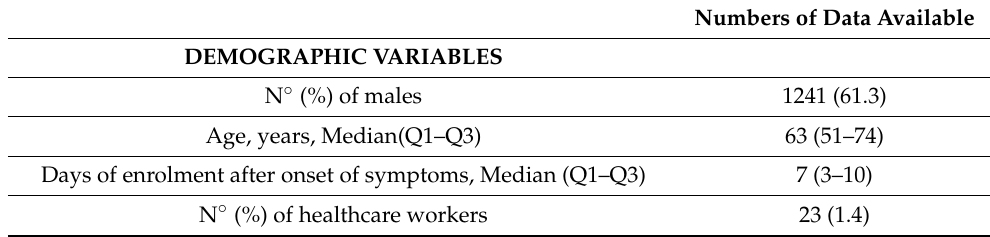
Table 1. Demographic, clinical and hematobiochemical data of patients included in the